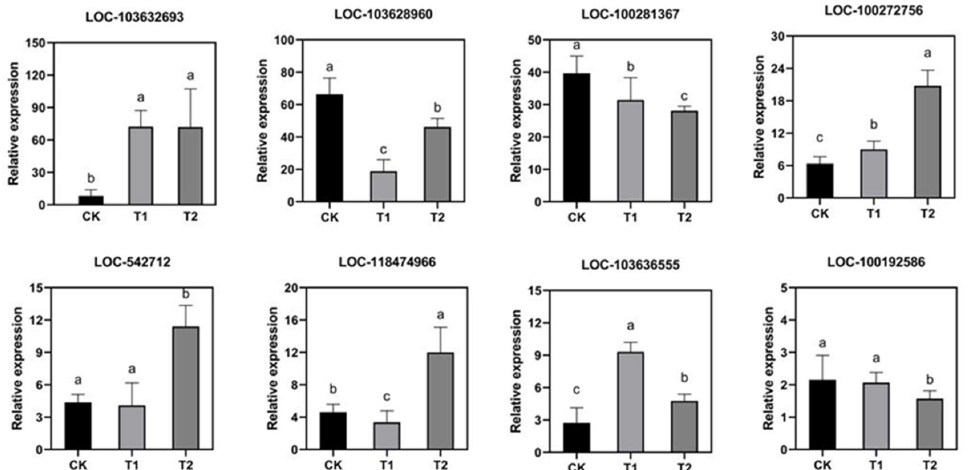
Figure 7. Verification of the reliability of the transcriptome data. Using Real-Time quantitative PCR, the expression levels of eight genes in T1 (drought at seedling stage), T2 (drought at flowering stage), and control CK were verified. The internal reference gene was Actin-1 . 90A1: LOC-103632693 , P47: LOC-103628960 , OsCAD1: LOC-100281367 , P450 73: LOC-100272756 , F3H: LOC-542712 , VvANR: LOC-118474966 , CYP2: LOC-103636555 , OsCAD1: LOC-100192586. Different lowercase means values significantly different at p < 0.05.